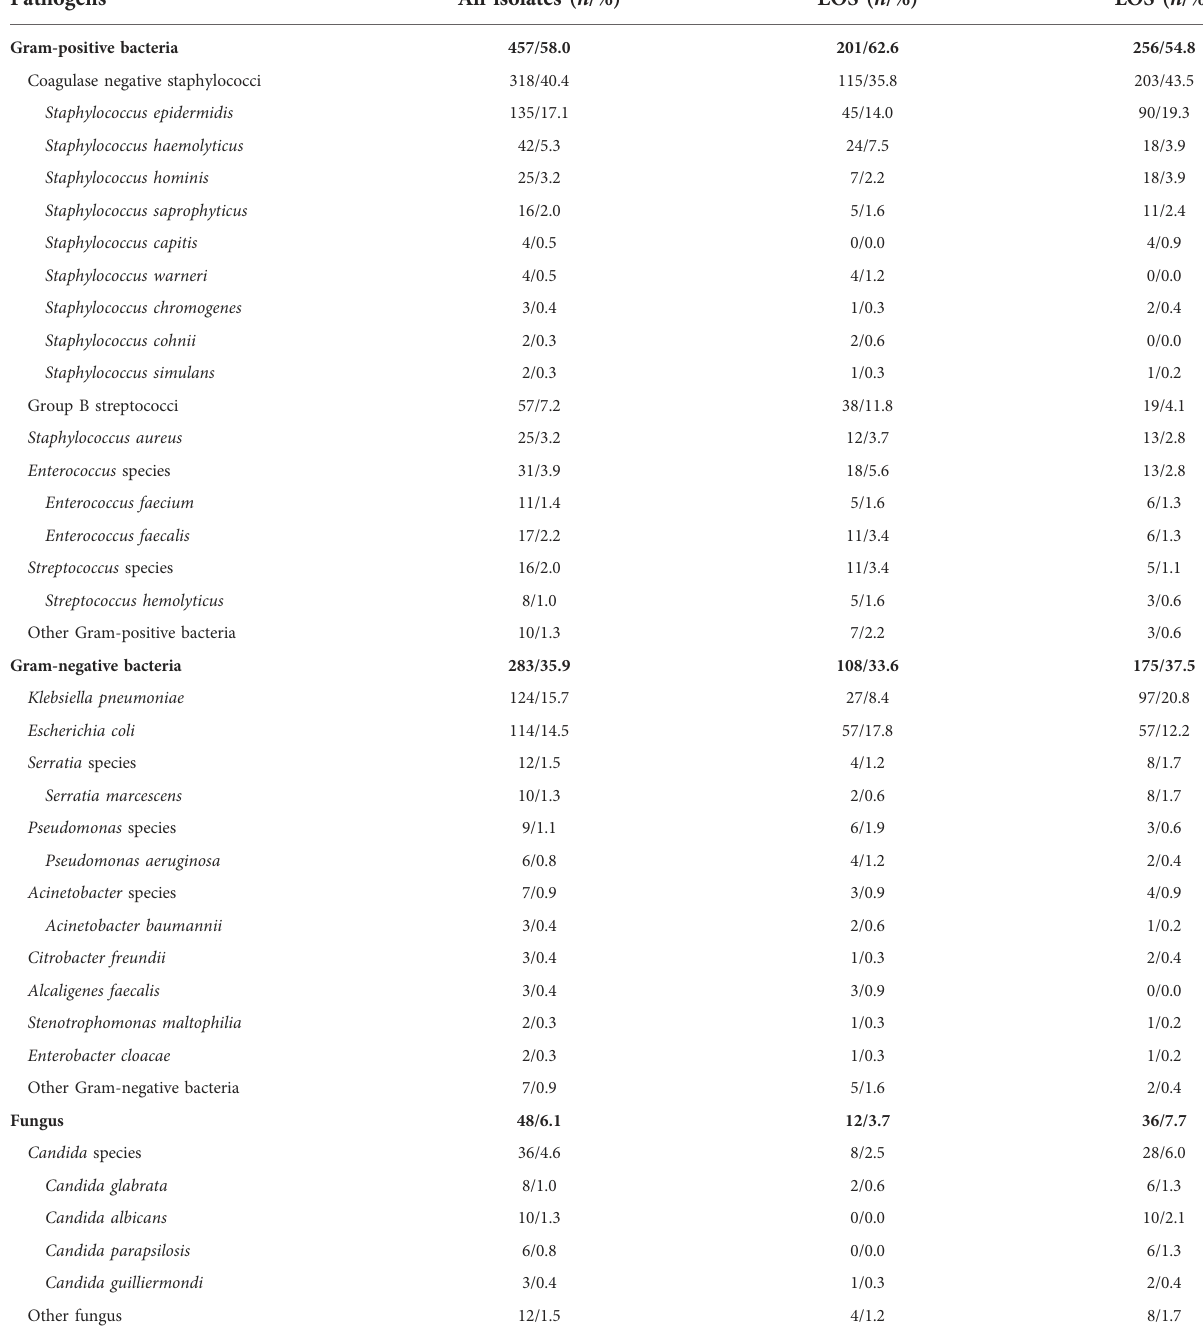
TABLE 1 Pathogen distribution of neonatal sepsis in 5 settings from central-south China, 2010 – 2019.